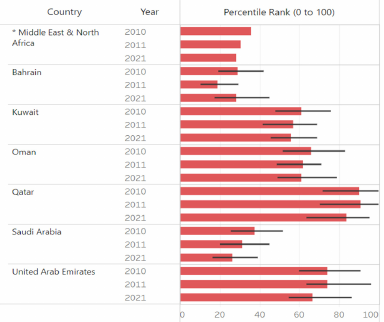
Figure 1. Political stability and * absence of violence in the Middle East. Source: Worldwide Governance Indicators [2]. Note: the higher the percentile rank, the more stable.